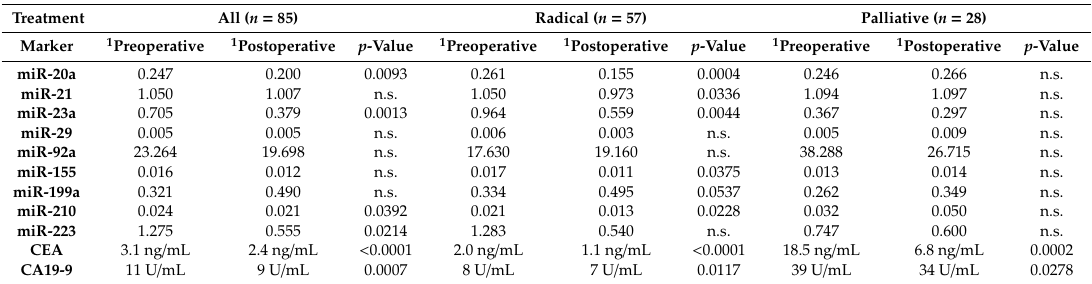
Table 1. Di ff erences in preoperative and postoperative levels of microRNAs, CEA, and CA19-9 according to type of surgery (radical or palliative). Treatment All ( n = 85) Radical ( n = 57) Palliative ( n = 28)